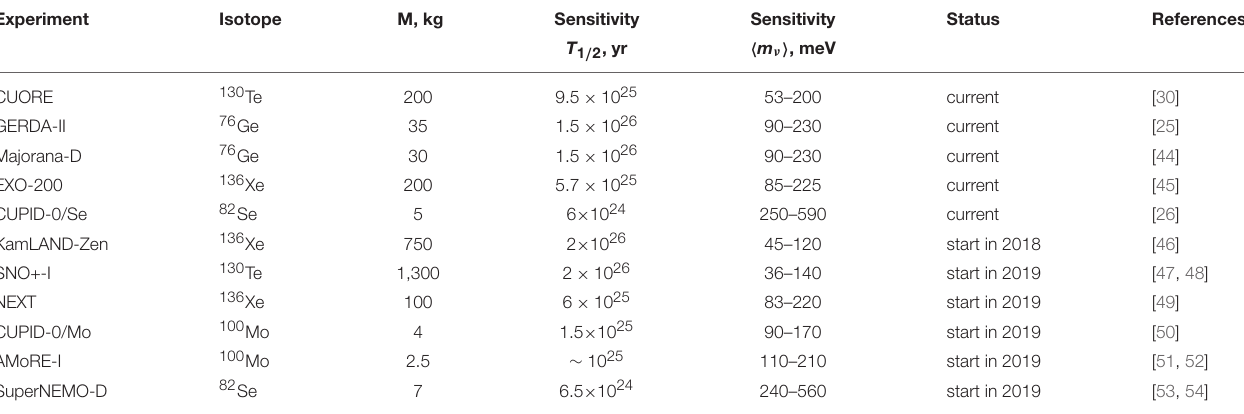
TABLE 2 | Best current and planned to start in 2018-2019 modern experiments. Experiment